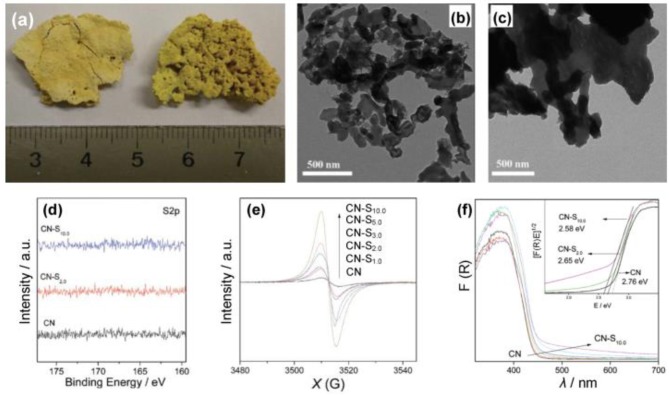
(a) Image of the g-C3N4 and CN-S2.0. (b) TEM images of CN-S2.0 and (c) unmodified g-C3N4. (d) High resolution XPS spectra of samples. (e) EPR spectra of samples in the dark. (F) UV–Vis spectra of samples (Zhang J. et al., 2012). Copyright 2012, American Chemical Society.